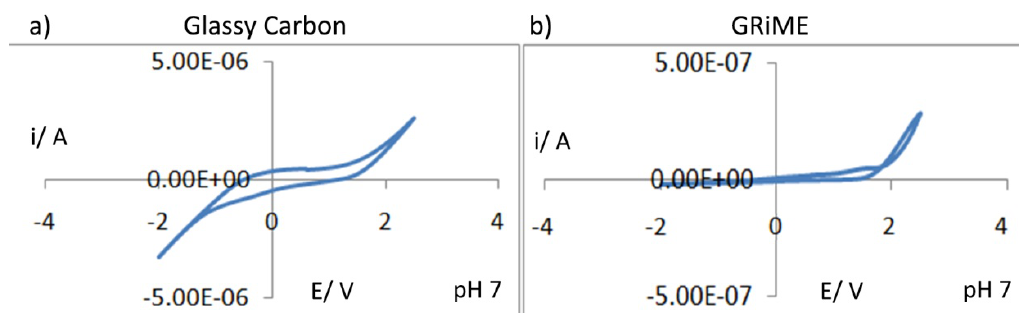
Figure 7. Comparison of CV’s recorded in aqueous background at pH 7 for a glassy carbon disk electrode (4 mm dia.) and a GRiME. CV’s were recorded over a potential range from − 2 to 2.5 V at a scan rate of 150 mV/s vs.